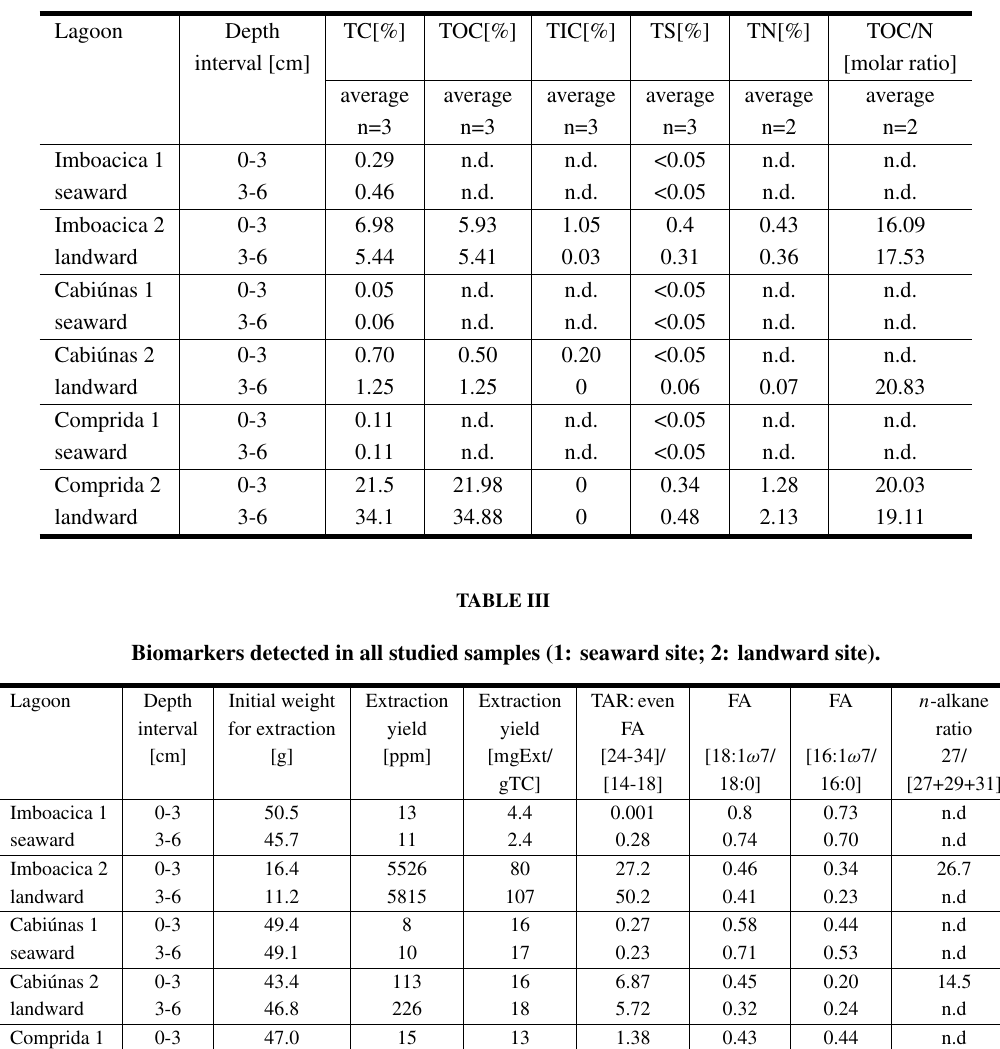
Elemental analysis data and organic carbon/nitrogen ratio in sediment samples from Imboacica, Cabiúnas and Comprida Lagoons (1: seaward site; 2: landward site).